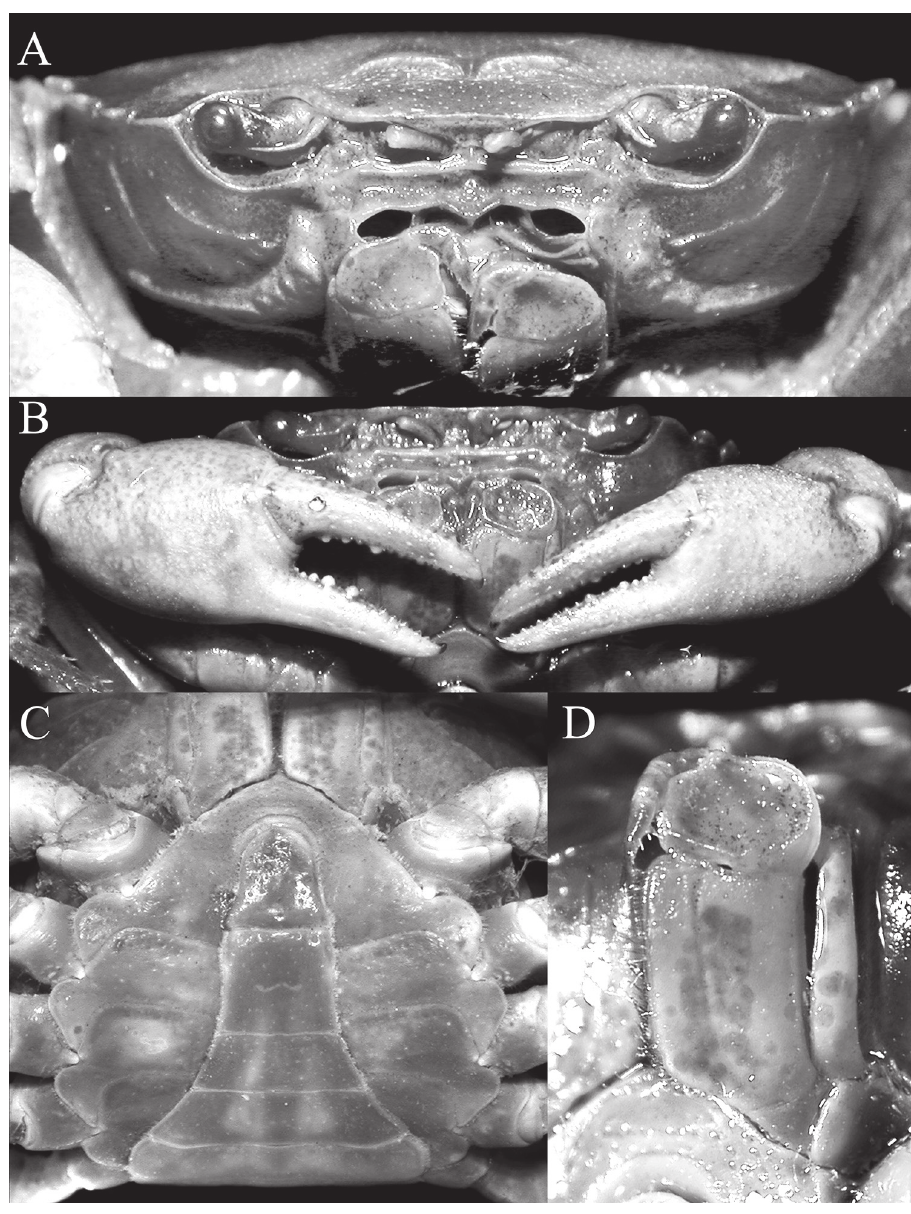
Figure 2. Salangathelphusa peractio sp. n., holotype: male (22.3 × 17.7 mm) (ZRC 2017.208), Lang- kawi. A frontal view of cephalothorax B outer view of chelae C anterior thoracic sternum and pleon D left third